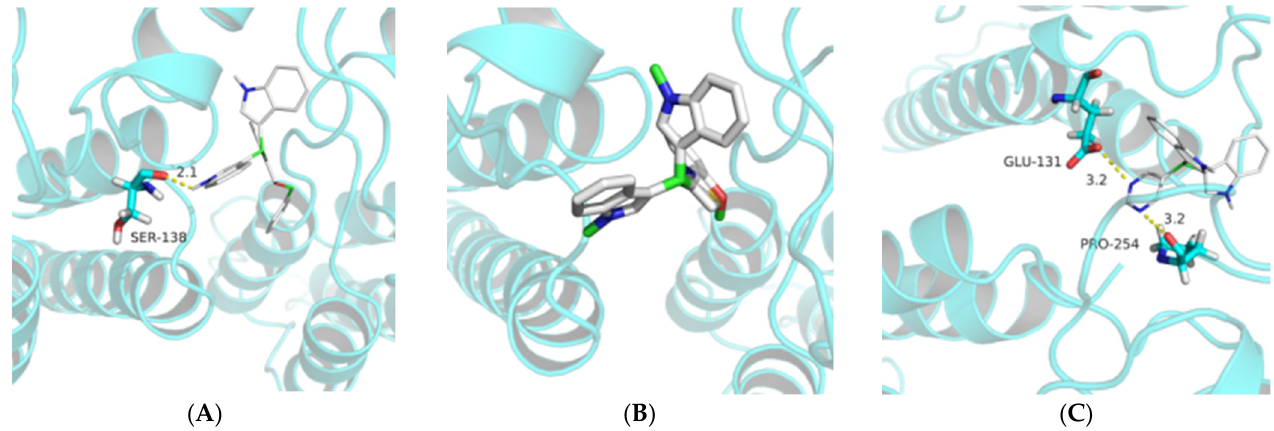
Figure 4. Molecule Docking Results of Compounds 8b ( A ), 9a ( B ) and 14b ( C ) with TMV CP.